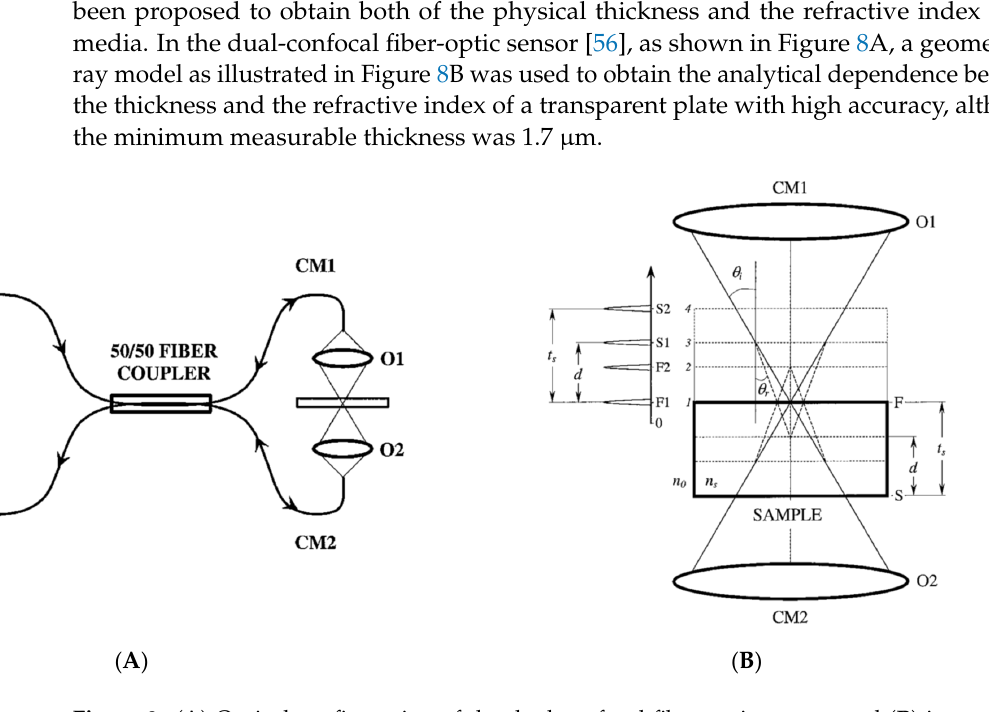
refractive index and thickness of PVI monolayer originated from Ref. [47]; SP, stagnation point; P,